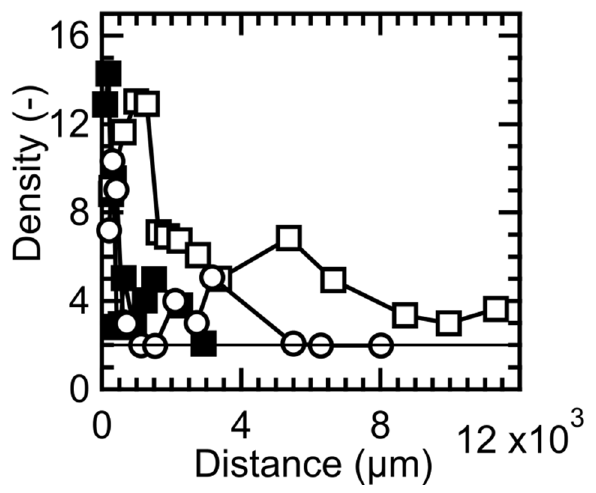
Figure 5. Distance from seed crystals vs. grain density plots. Open circles: 75 K/mm (400 V/cm); open squares: 73.4 K/mm (1000 V/cm); filled squares: 55 K/mm (1000 V/cm) [23]. A solid line corresponds to the existence of two domains in fiber crystals.